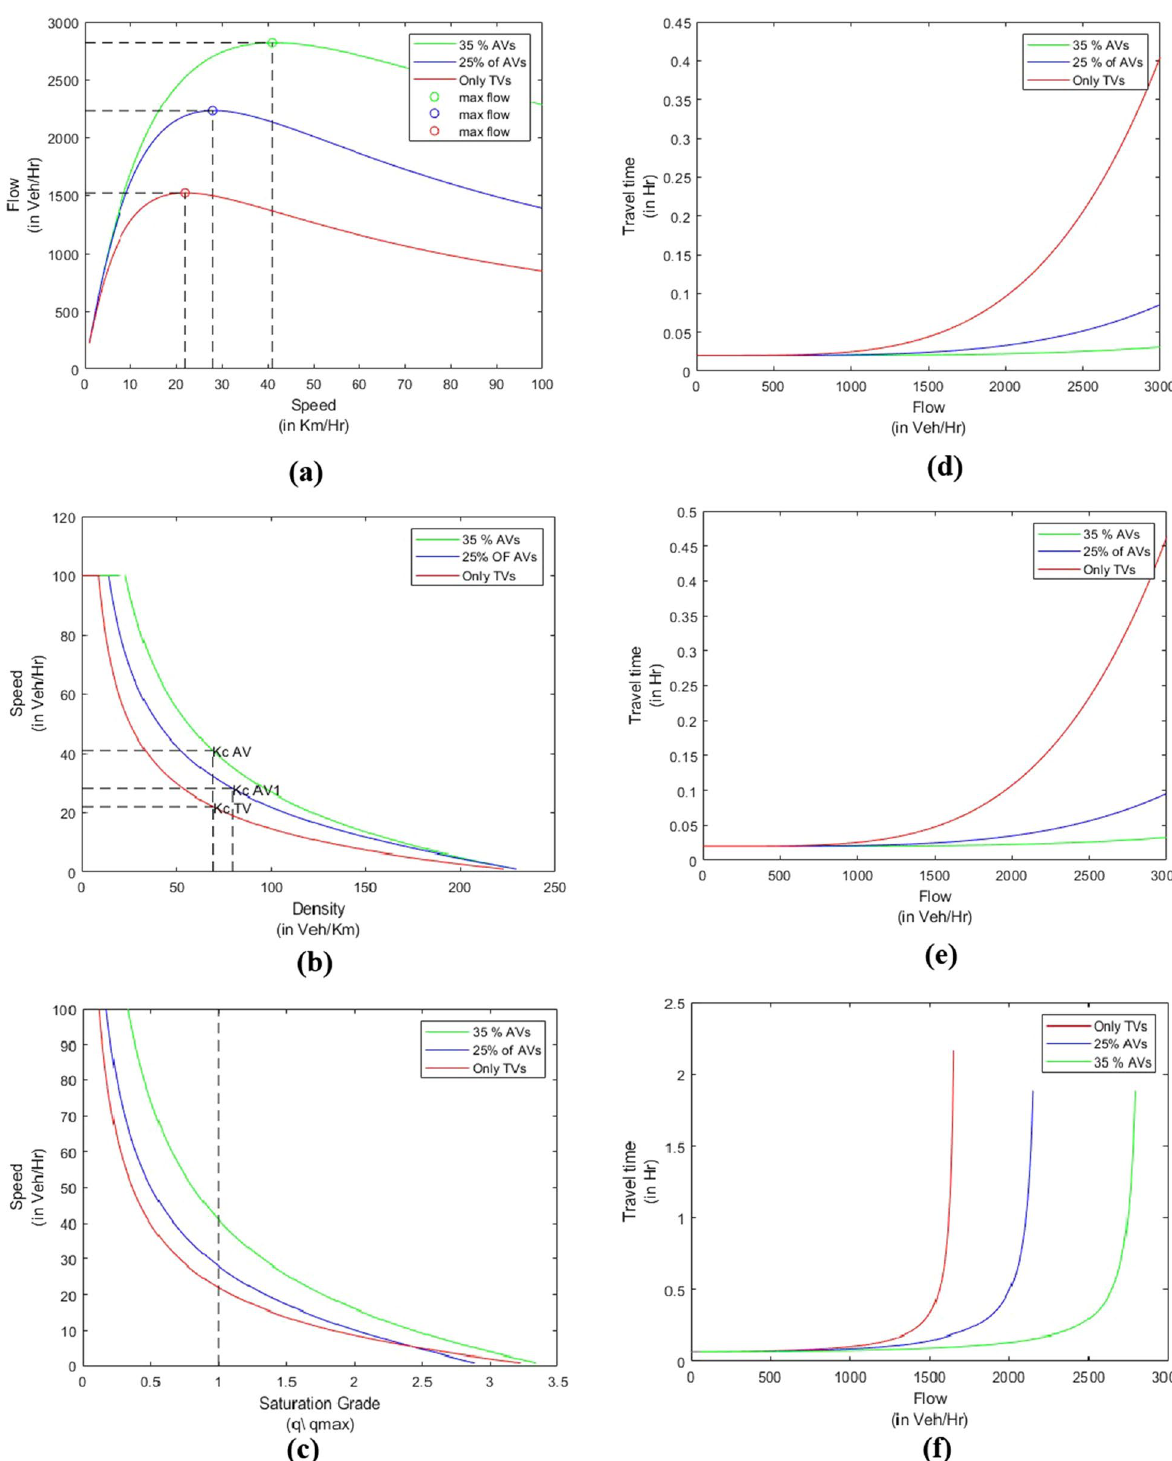
Fig. 4 a Speed-flow relationship for Scenario 0 and scenario A under sensitivity range of AVs; b Speed-Density relationship for Scenario 0 and scenario A along with critical densities under sensitivity range of AVs; c decrement in vehicle speed with respect to Saturation grade; d Travel-time flow relationship with a link having physical median and no influence of opposite direction flow under sensitivity range of AVs; e Travel-time flow relationship without a link having physical median and influence of opposite direction flow under sensitivity range of AVs; f Travel-time flow relationship with physical and functional characteristics of links affecting travel time under sensitivity range of